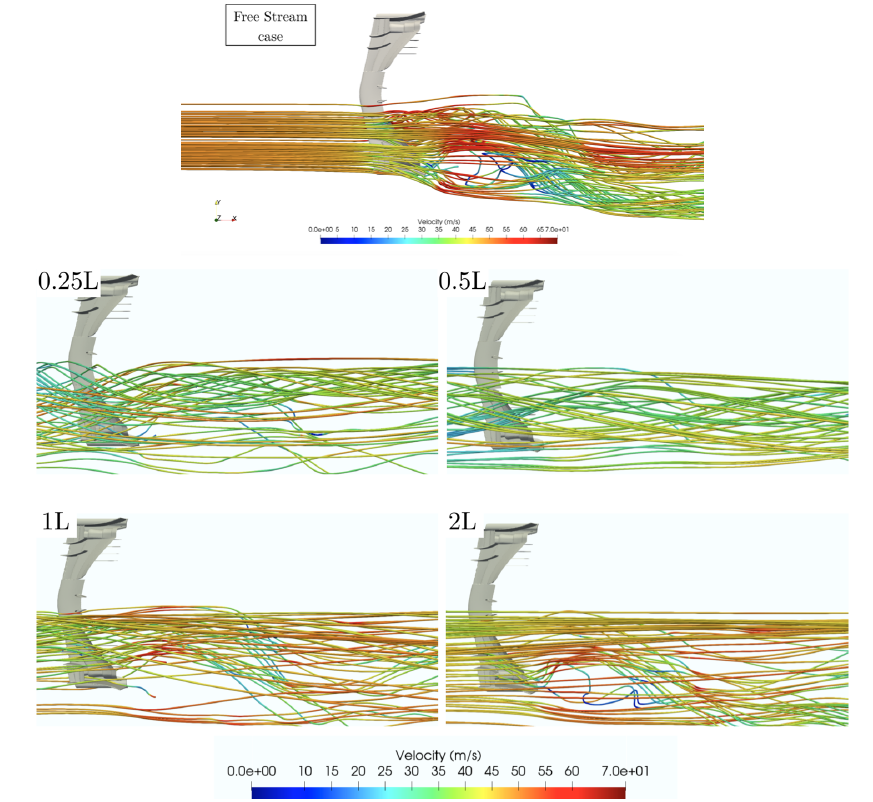
Figure 18. Streamlines of the velocity. Front wing of the second car at a distance of 0.25 L, 0.5 L, 1 L, and 2 L as compared to the free stream case.